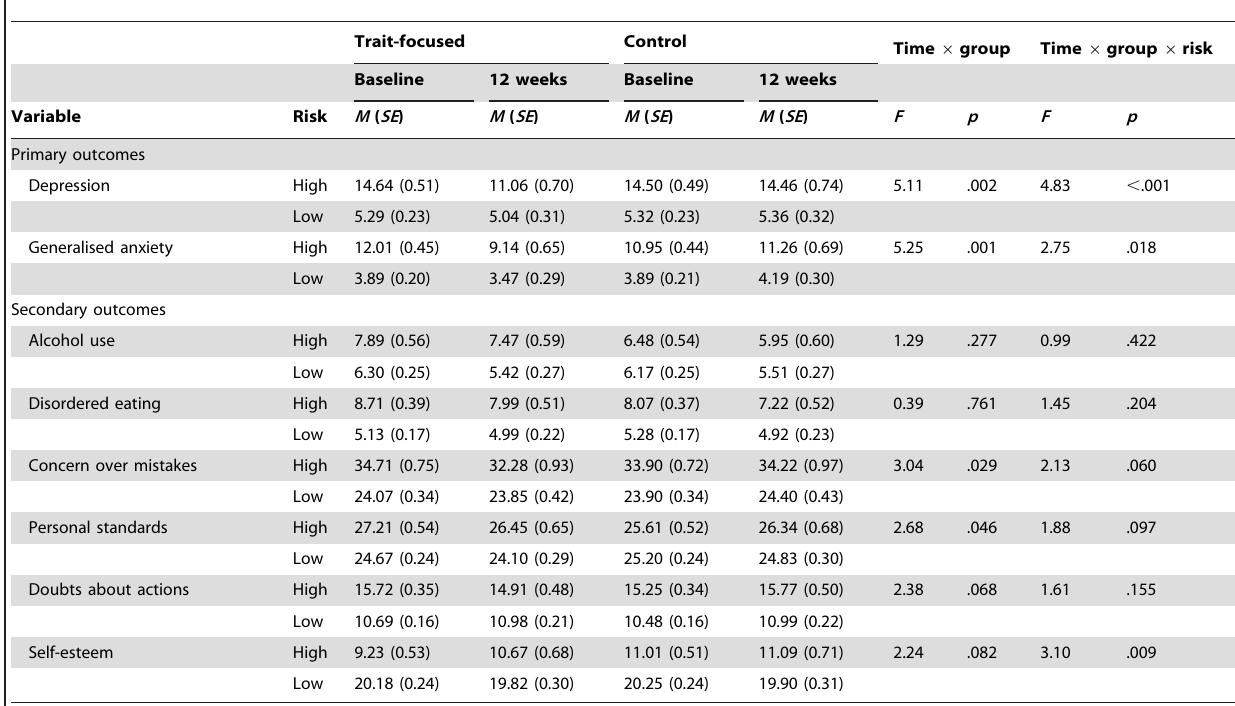
Table 4. Estimated means for intervention and control group, by risk status and results of the linear mixed models analysis.